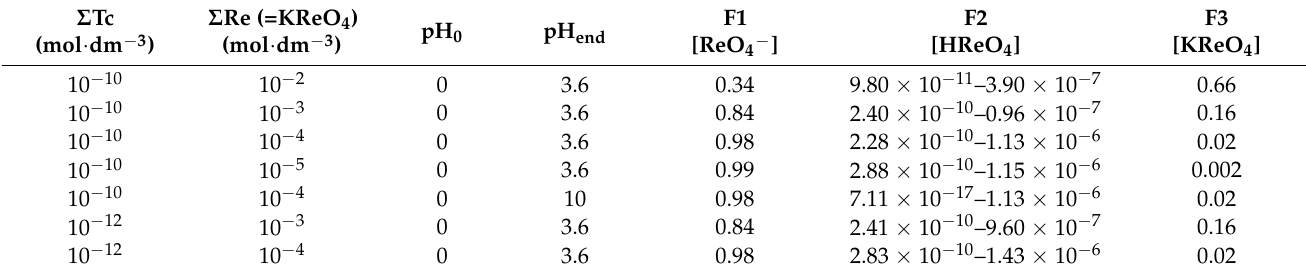
Table 5. Mole fractions calculation result. (The values of F2 correspond to the values of pH 0 and pH end , respectively. The values of F1 and F3 are function of Σ Re (=KReO 4